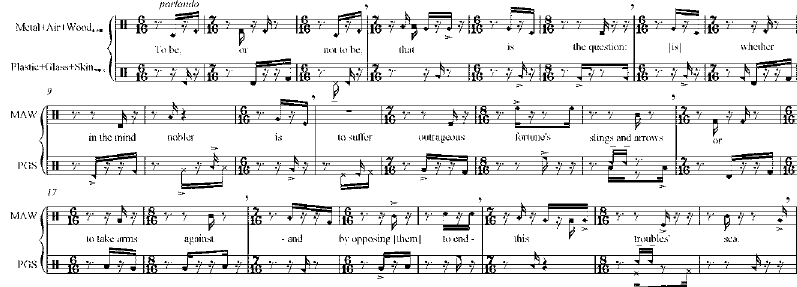
Figure 8: Progéthal Percussian for the Advanced Beginners : Hamlet’s Soliloquy ( bars